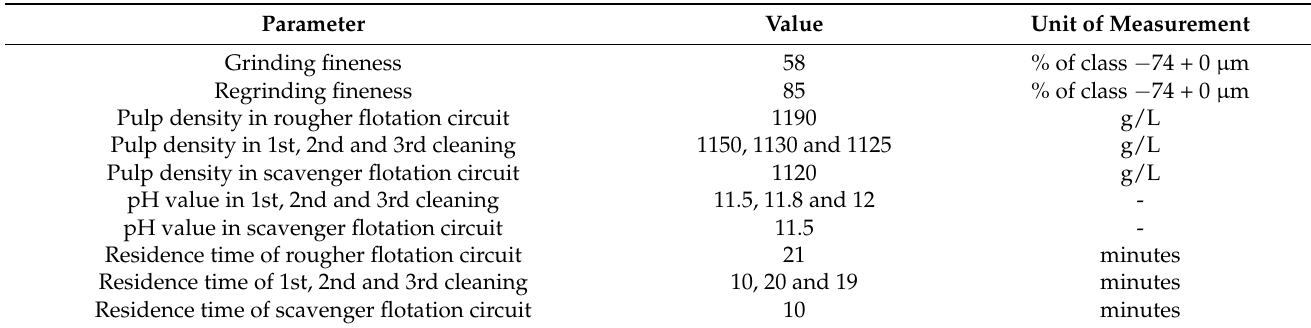
Table 2. Input variables that are considered constant.